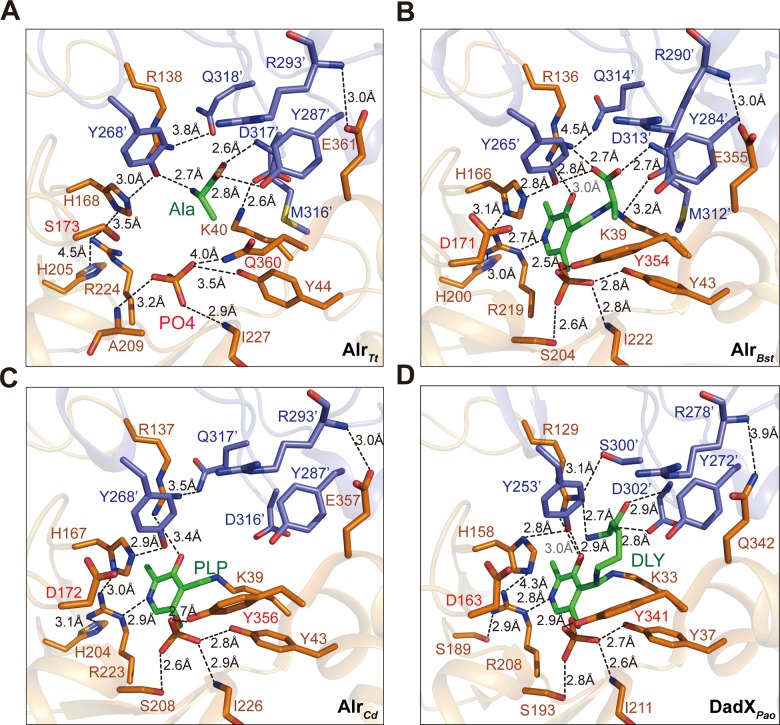
Comparison of the active site pocket of AlrTt with other three bacterial alanine racemases.
(A) The active site pocket of AlrTt (PDB 4Y2W), phosphate group, L-Ala and key amino acids that involved in substrate binding are shown in sticks, the hydrogen bonding interactions are indicated. Same view of the active site pocket of other three bacteria alanine racemase in complex with substrates are shown in same profile: (B) the PLP-D-Ala complex of AlrBst (PDB 1L6G), (C) PLP complex of AlrCd (PDB 4LUS), (D) PLP and DLY complex of DadXpao (PDB 1RCQ).